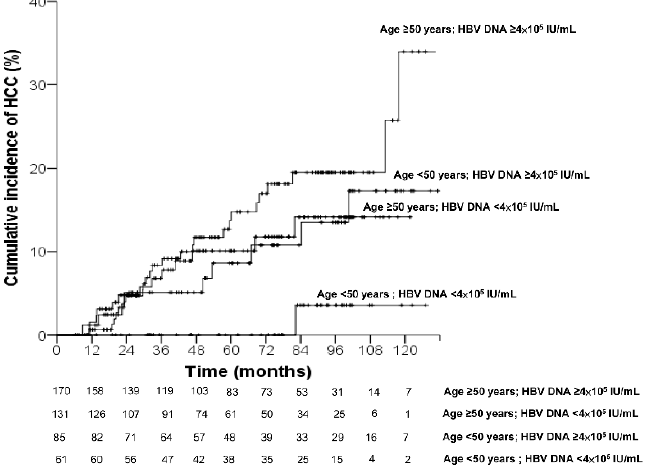
Figure 3. Cumulative incidence of hepatocellular carcinoma according to age and HBV DNA .